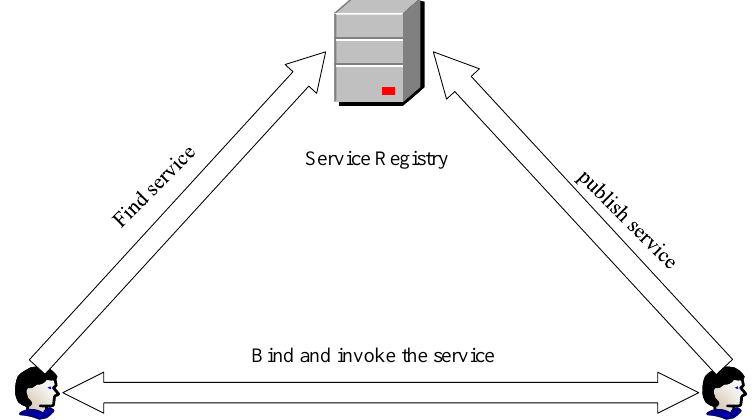
Figure 2. Middleware working